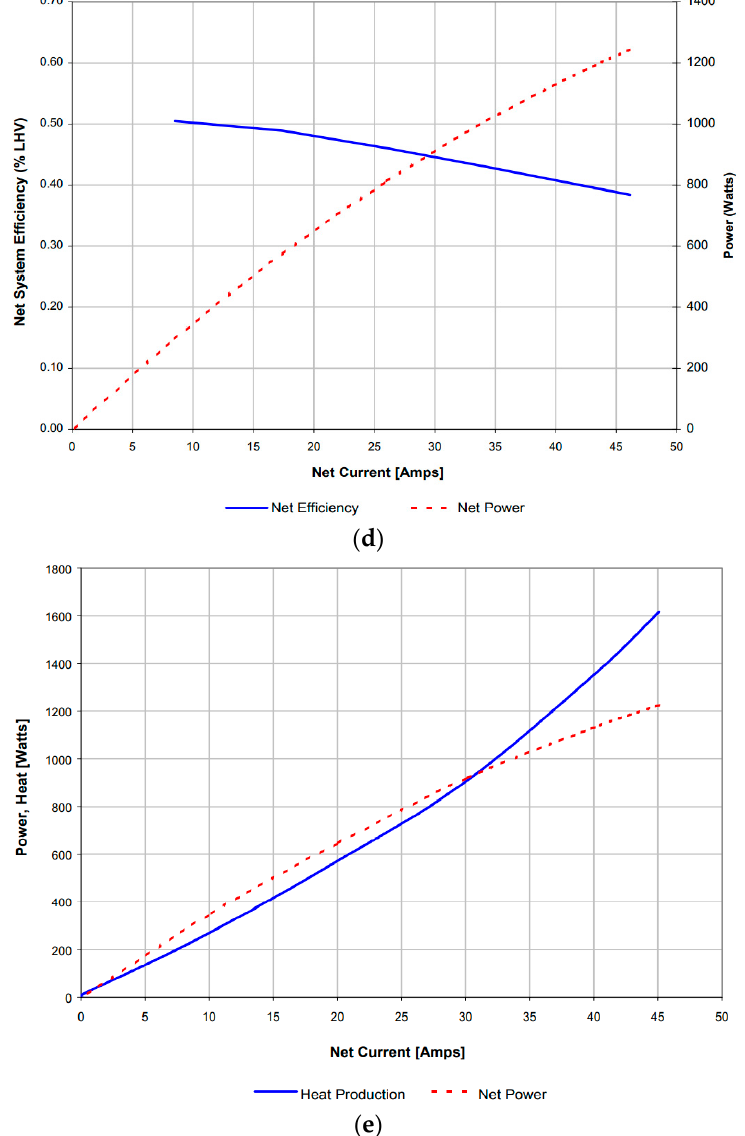
Figure 5. ( a ) Fuel cell response with respect to time. ( b ) Polarization and power curves for the 1.2 kW Nexa fuel cell. ( c ) Rate of hydrogen consumption. ( d ) Efficiency of the system. ( e ) Waste heat produced from the module.